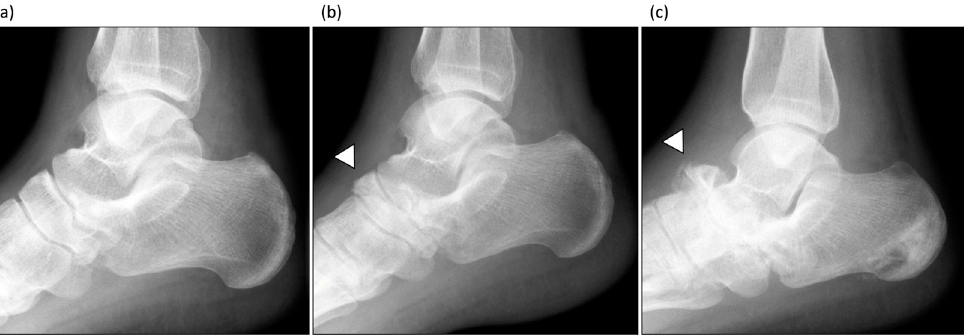
Figure 1. Plain radiographic findings of CN. ( a ) Immediately after onset, no changes in the bone were visible; ( b ) 1 week after onset, a bone fracture was observed (arrowhead); and ( c ) 1 month after onset, joint deformity was observed (arrowhead). CN, Charcot neuroarthropathy.